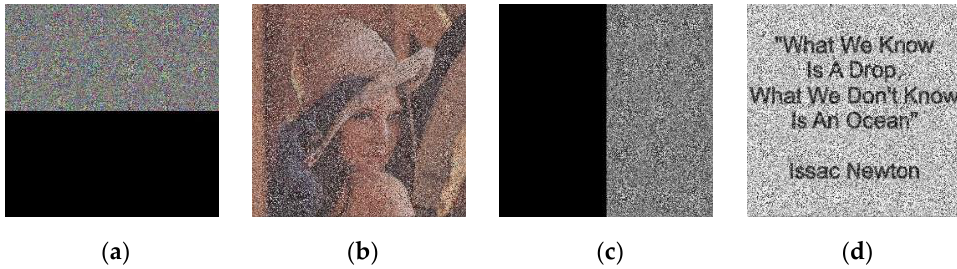
Figure 9. ( a ) Lena_encrypted.jpeg with 50% occlusion in different zones, ( b ) Decryption of Lena_encrypted.jpeg after 50% occlusion attack, ( c ) Message_encrypted.jpeg with 50% occlusion in different zones, ( d ) Decryption of Message_encrypted.jpeg after 50% occlusion attack.